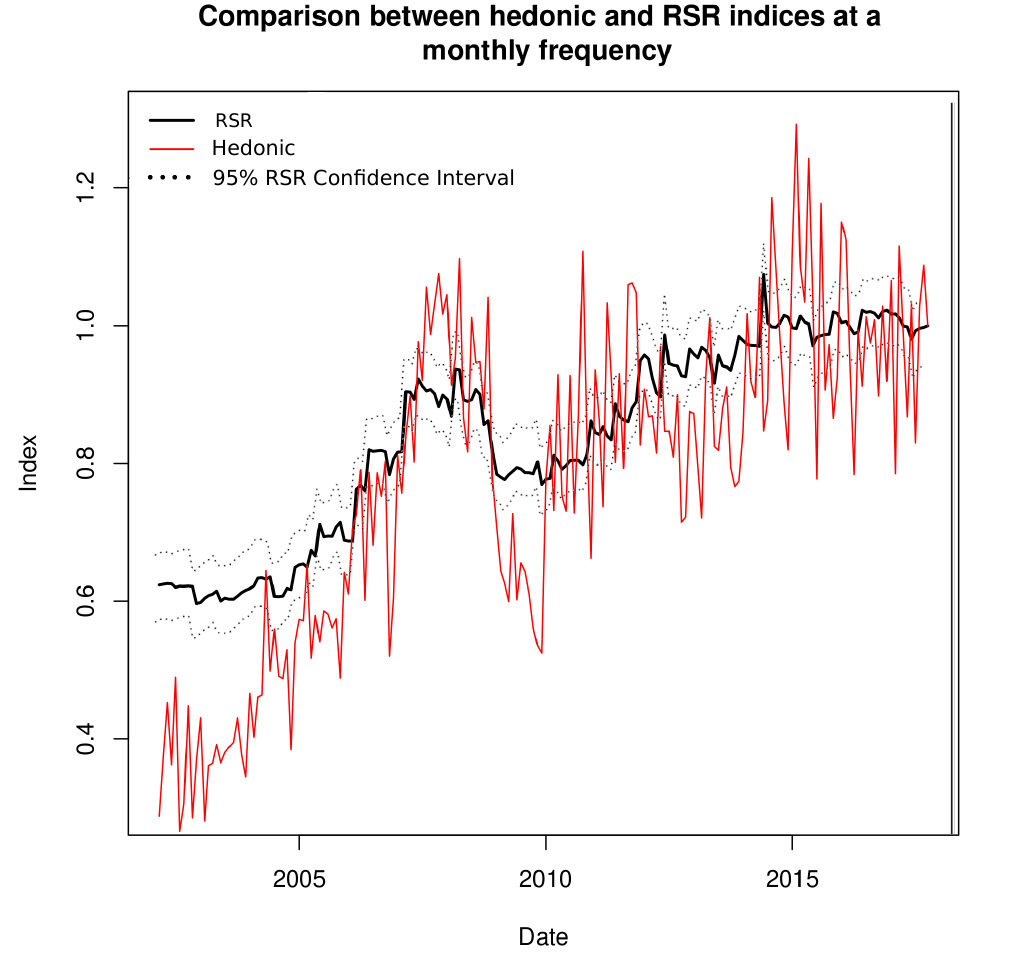
Figure 1. Kalman-repeat-sales regression (RSR) vs.